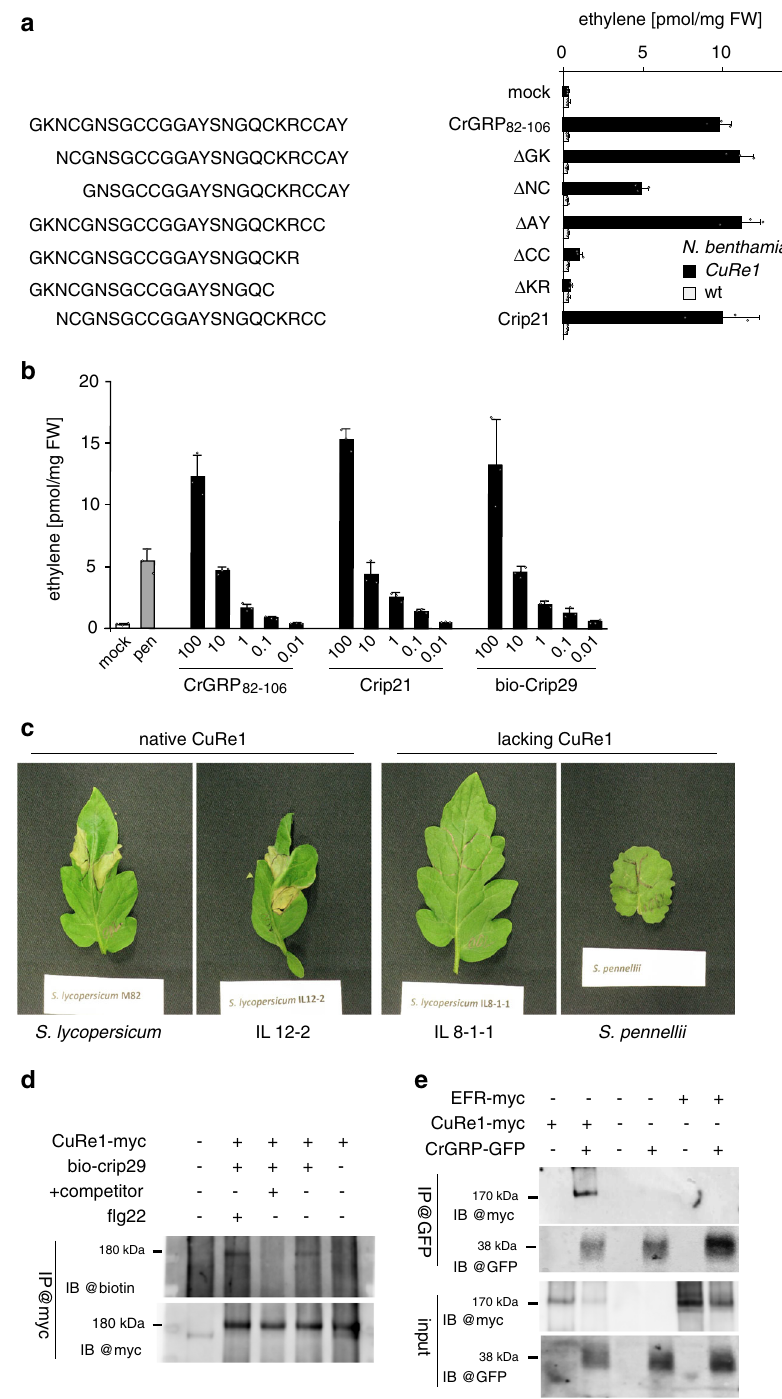
Fig. 3 The peptide epitope crip21 of CrGRP triggers the tomato receptor CuRe1. a Synthesized peptides deriving from CrGRP induce ethylene production in transgenic CuRe1-expressing N. benthamiana . Peptides were applied at concentrations of 1 µ M each. b Dose-dependent induction of ethylene by the CrGRP derived, synthesized peptides in CuRe1 -expressing N. benthamiana ; numbers on x-axis indicate peptide concentrations in nM; bio-crip29 is the N- terminally biotinylated peptide used in binding studies; for a and b: Bovine serum albumin (BSA; 0.01 mg/ml) buffered in 25 mM MES (pH 5.7) was added as mock control; Penicillium extract (0.05 mg/ml) served as positive control 31 . FW, fresh weight; ethylene measurements show means of three technical replicates; dots indicate single data points; error bars denote SD, representative graphs are shown, experiments were repeated independently more than three times. c crip21 peptide induces HR-type of cell death in a CuRe1-dependent manner. Leaves of S. lycopersicum , an introgression line (IL 12-2) with functional CuRe1and leaves of IL 8-1-1 and S. pennellii (right; both lacking CuRe1) were in fi ltrated with 100 nM crip21 and photographs were taken 7 days later; painted lines indicate in fi ltrated leaf area. The effects shown are representative for ten in fi ltrated leaves per tomato IL or species, respectively; experiments have been independently repeated three times. d Af fi nity-crosslinking of crip29-biotin with CuRe1 in planta. Solubilized proteins were immune-precipitated and analyzed for myc-tagged (bottom) and biotinylated proteins (top); CrGRP 82-106 served as competitor; e Co-immunoprecipitation experiments demonstrate interaction of CuRe1 with CrGRP full length protein after co-expression for ~48 h in planta